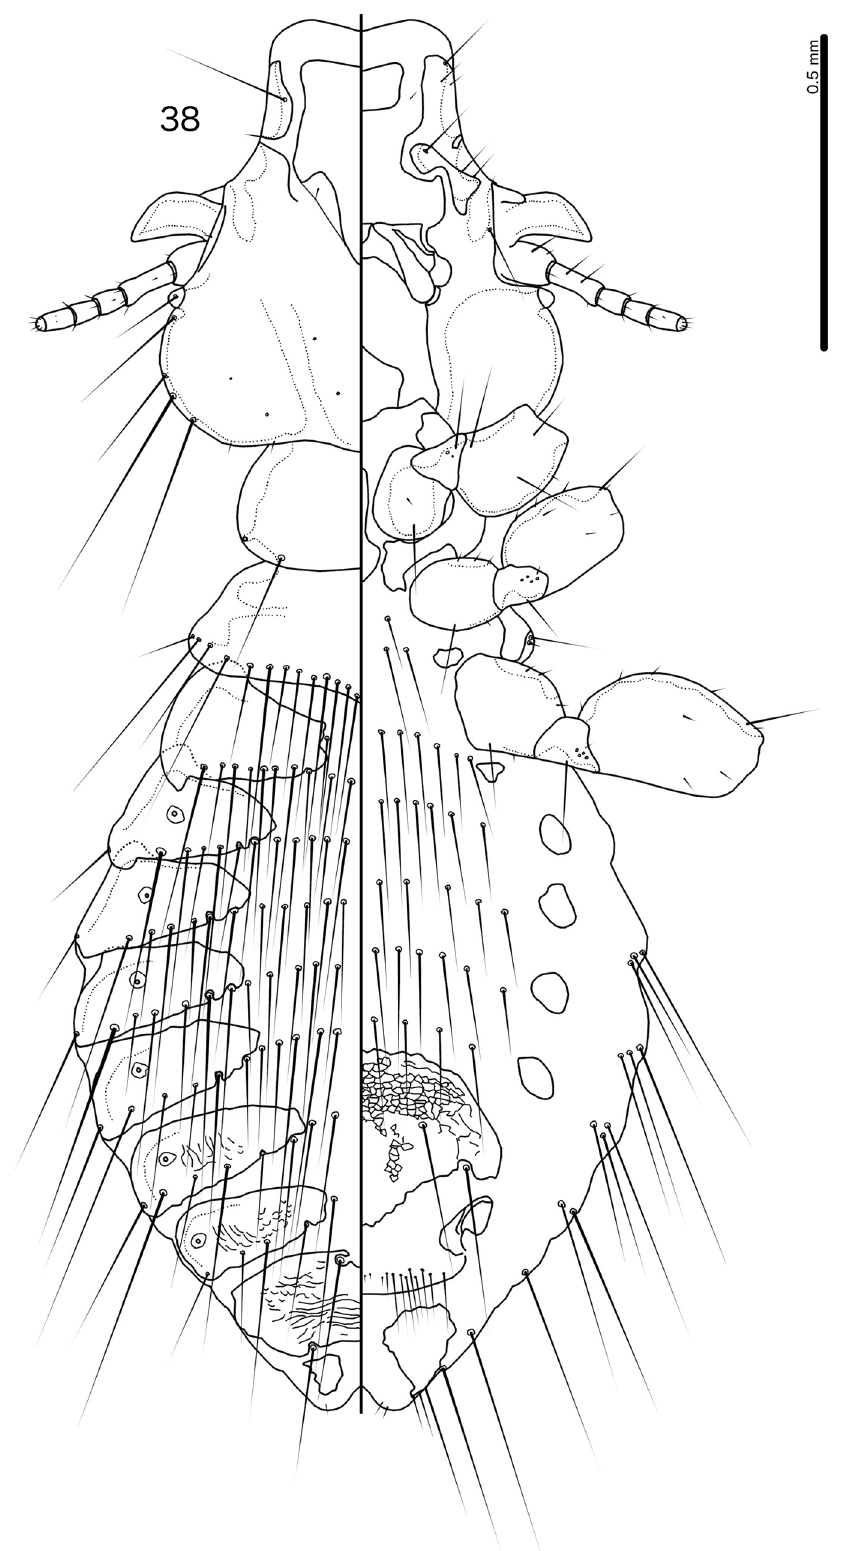
Fig. 38. Philopterus coriaceus sp. nov. ex Molothrus oryzivorus oryzivorus (Gmelin, 1788), female habitus, dorsal and ventral